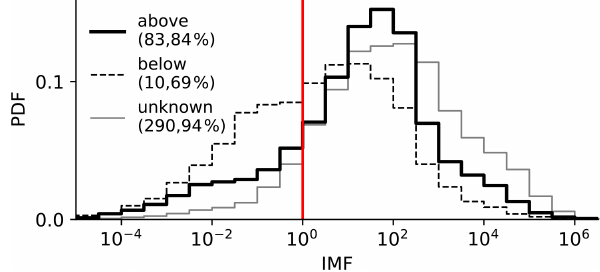
Figure 11. Probability density functions (PDFs) of obtained ice multiplication factors (IMFs, Eq. 12) for ice crystal number con- centration data above cloud base (solid black), below cloud base (dashed black), and of unknown cloud base (solid gray). The solid red line indicates unity. The median IMF and the percentage of IMF larger unity for each PDF are given in the